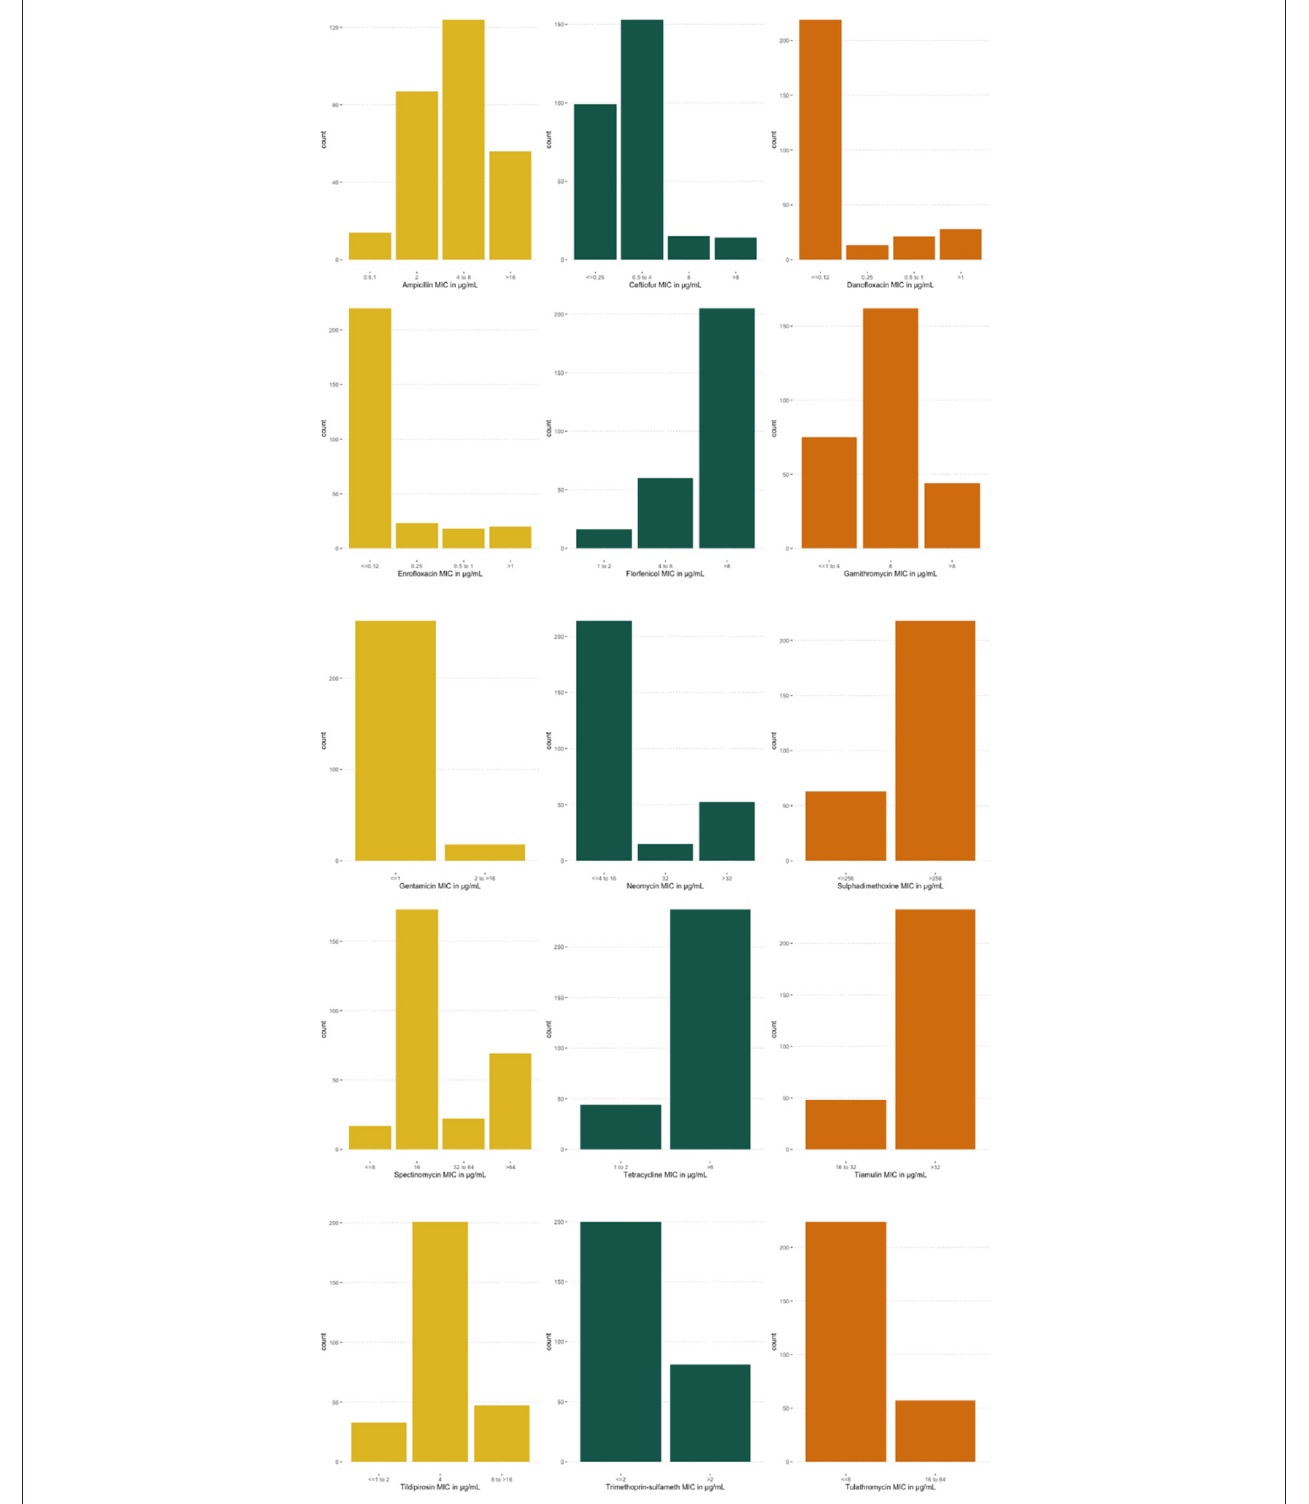
FIGURE 1 | Distributions of minimum inhibitory concentrations (MIC) for Escherichia coli ( E. coli ) isolates. MIC distribution for E. coli isolates, collected from five farms for 15 antibiotics, analyzed in Bayesian network analysis.